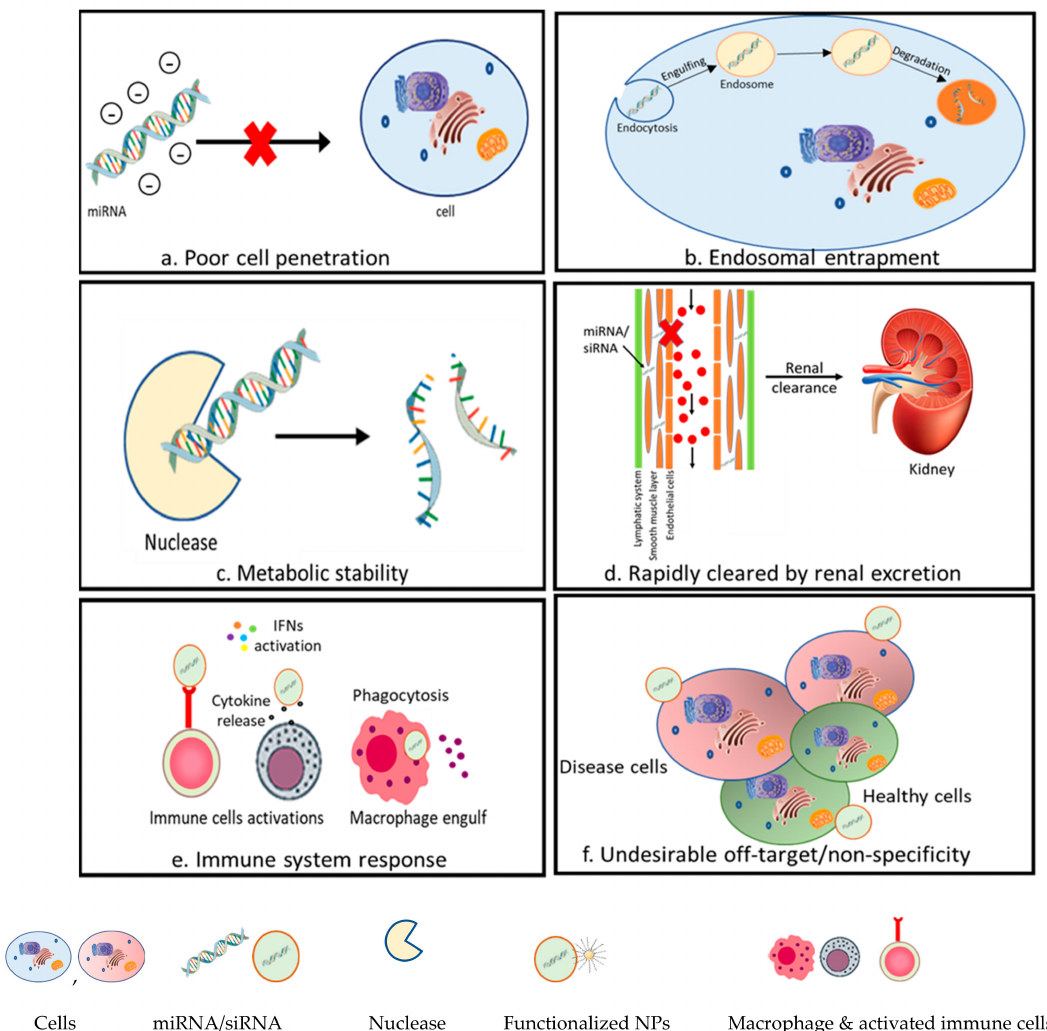
Figure 2. The challenges of in vivo miRNA/SiRNA